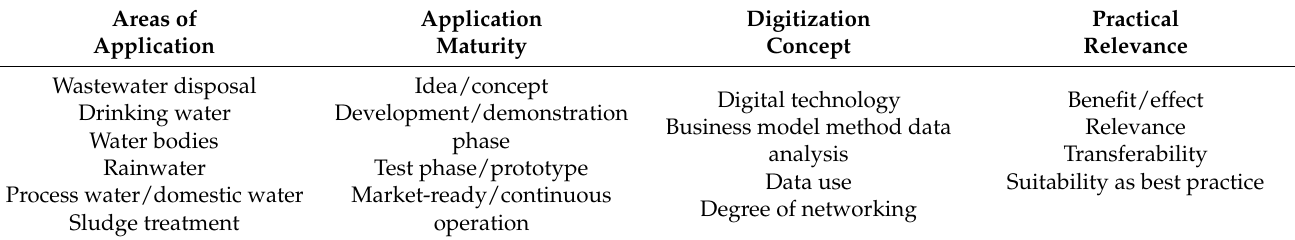
Table 1. Aspects and categories for the evaluation of the identified digitization